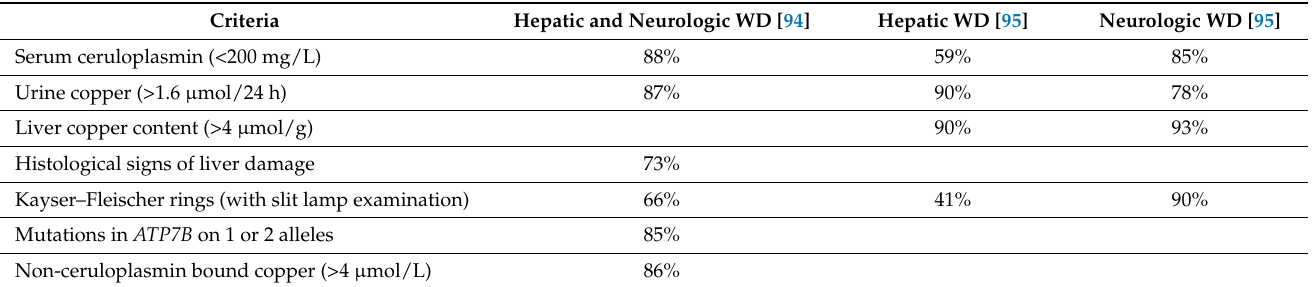
Table 1. Relative frequency of diagnostic markers present in a retrospective study of Wilson’s disease (WD) patients